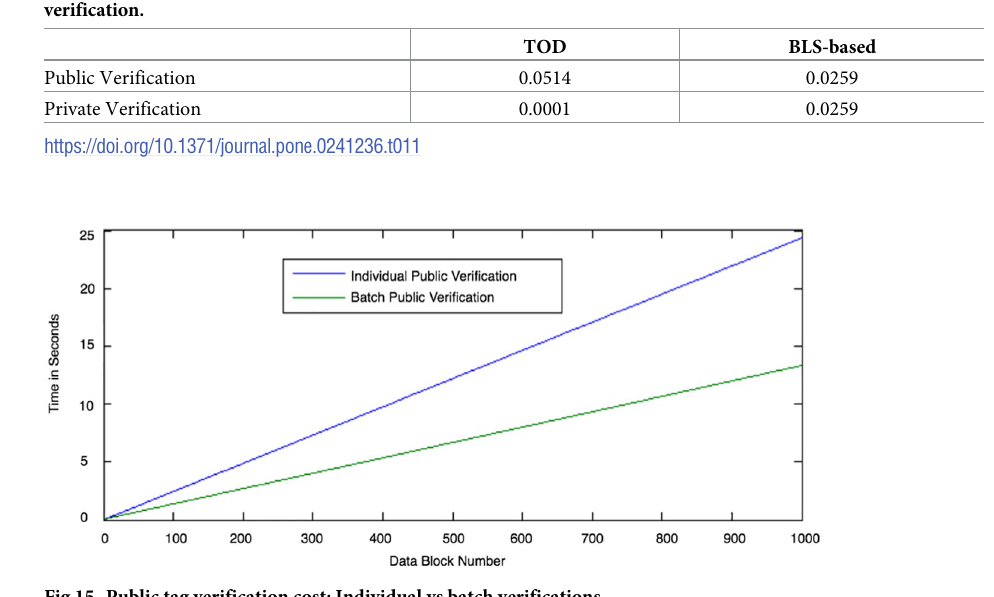
Fig 15. Public tag verification cost: Individual vs batch verifications.